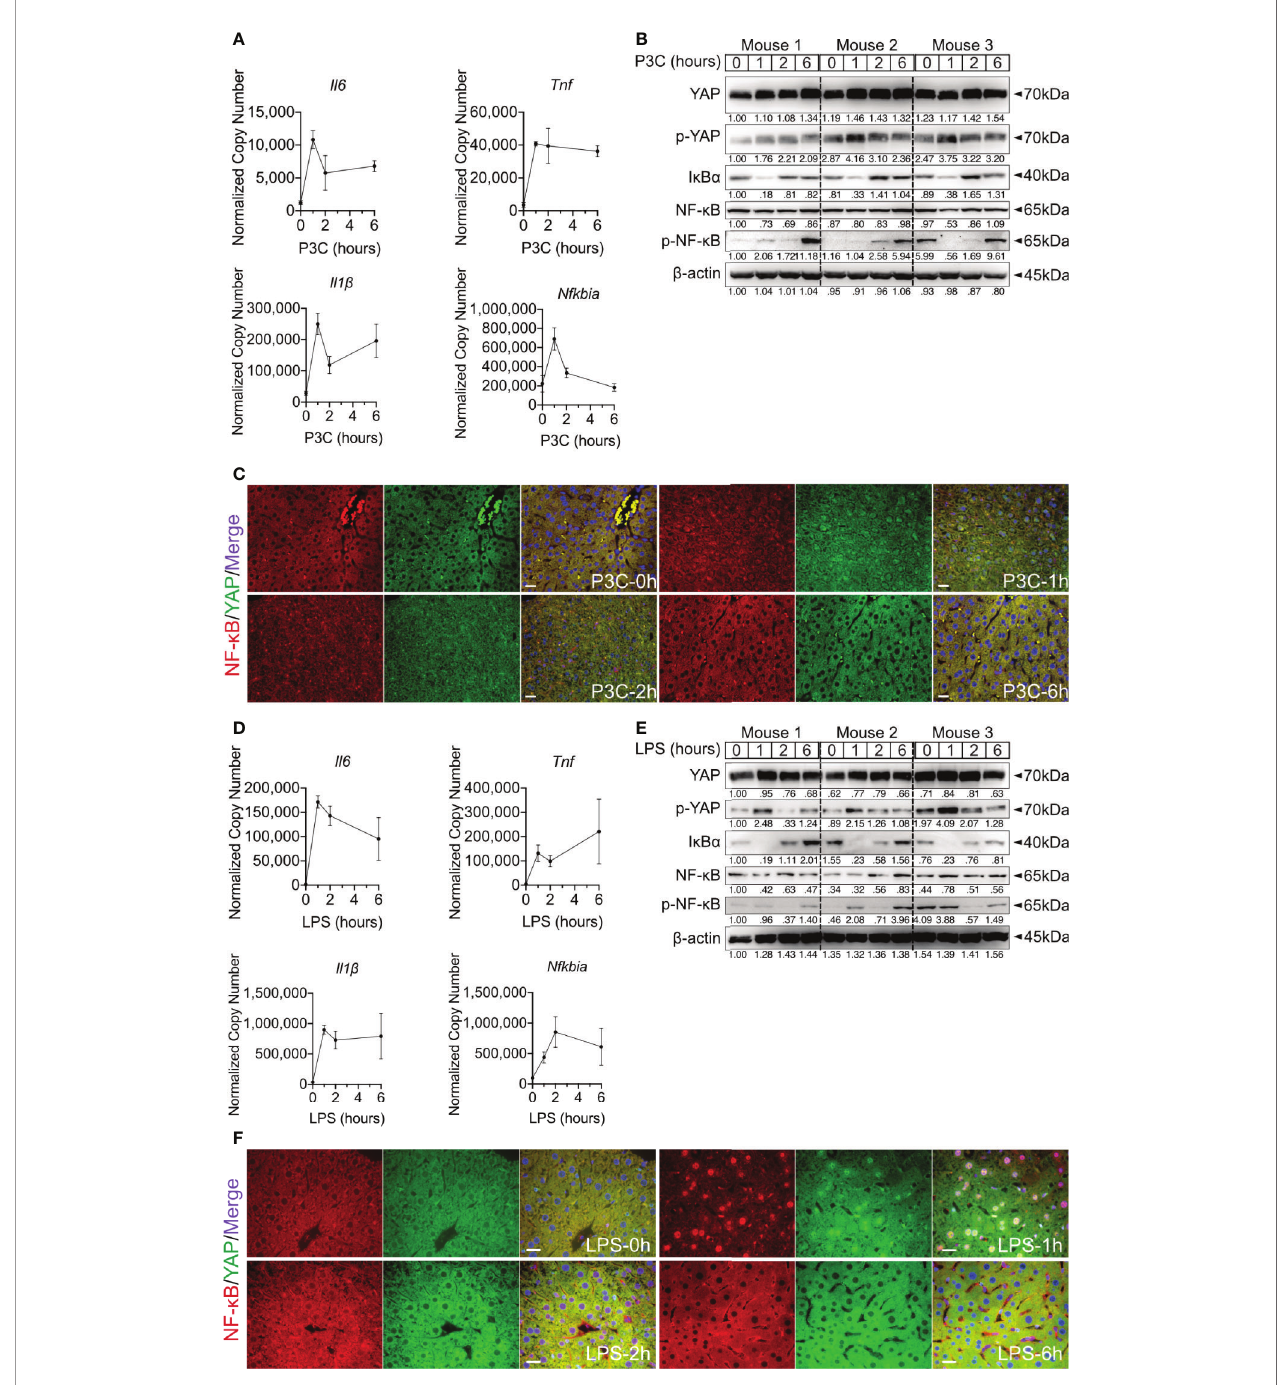
FIGURE 4 | Hepatic TLR-Hippo axis plays an important role in innate immunity in vivo . Two-month-old male C57BL/6 mice (group size n=3) received intra venous Pam3CSK4 (P3C, 1mg/kg bodyweight) or intra peritoneal LPS (2.5mg/kg bodyweight). After 0-6h liver samples were prepared and analyzed. Quantitative PCR was performed to detect hepatic Il6 , Tnf , Il1 b and Nfkbia expression 0h, 1h, 2h and 6h after injection of P3C (A) or LPS (D) . Accordingly, YAP, phosphorylated YAP, I k B a , NF- k B and phosphorylated NF- k B were analyzed by western blot (B, E) treatment. Gel images were obtained with ADVANCED Fluorescence and ECL Imager. ICC staining was performed and images were obtained with Zeiss AxioObserver.Z1 and Apotome (40x objective) to visualize the intracellular localization of YAP (green) and NF- k B (red) at 0h, 1h, 2h and 6h after P3C (C) or LPS (F) administration. Raw images were subsequently proceeded with Image J software. Group size N=3; Scale bar, 20 m m; kDa,